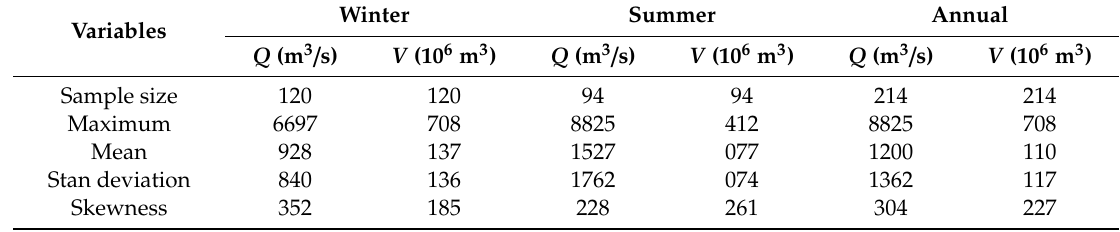
Table 4. Basic empirical statistics of Q, V for the di ff erent samples considered.